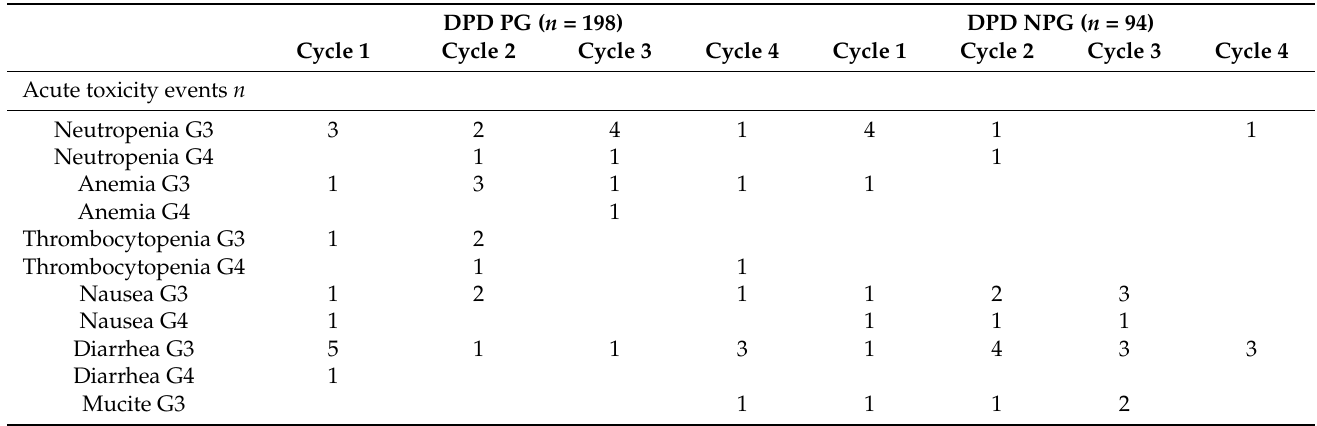
Table 3. Acute severe toxicities encountered (NCI grading).